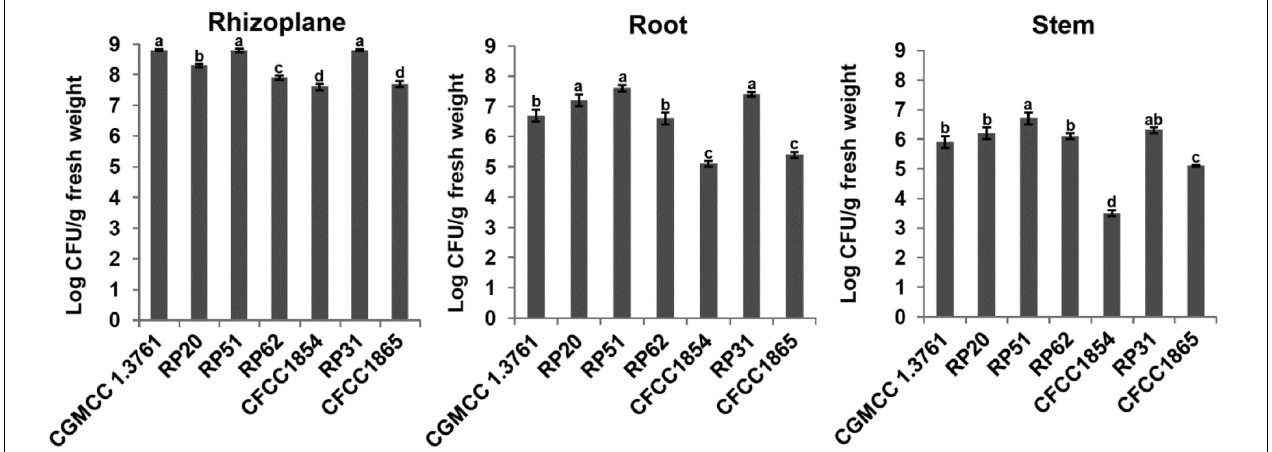
FIGURE 5 | Colonization of wheat seedlings by Paenibacillus peoriae CGMCC 1.3761 T and nodule-inhabiting strains within P. polymyxa complex. Bacteria were recovered at 9 days after inoculation to imbibed wheat seeds. The different letters on the columns and standard error bars indicate significant difference between the treatments at p < 0.05. TABLE 4 | Growth parameters of wheat seedlings inoculated with strains within Paenibacillus polymyxa complex. Treatments Seed germination (%)* Root length (mm)* Shoot length (mm)* Dry weight (mg)* Control without inoculation